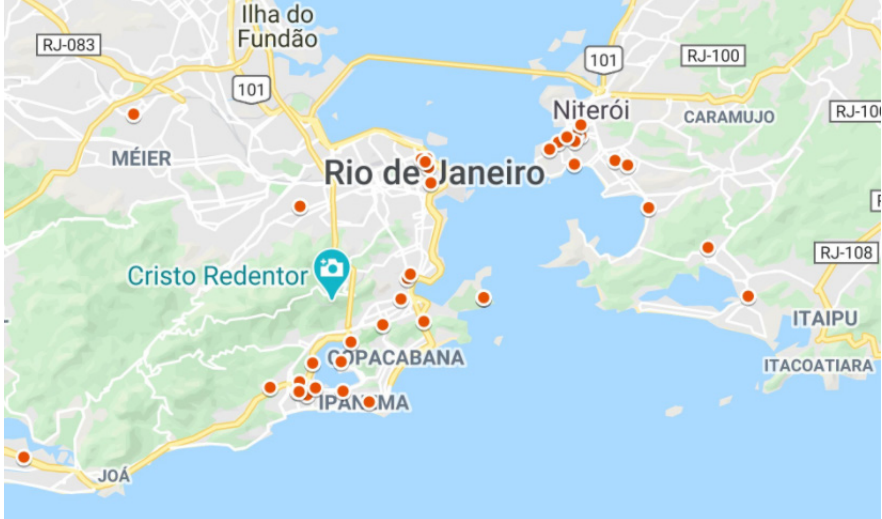
Figure 1. Terminal points installed. Table 8. Local types and percentage of withdrawals per locale.